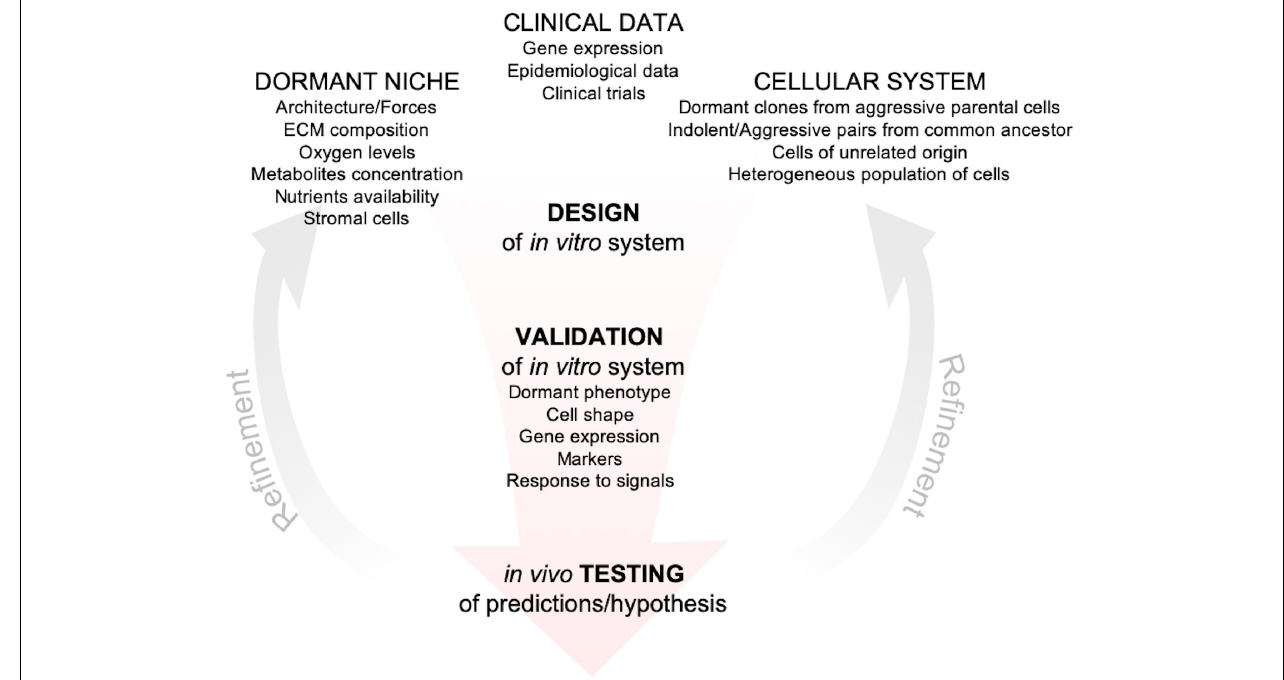
FIGURE 1 | Framework for the development of in vitro models of metastatic dormancy. In vitro models should include one or more features of the dormant niche starting from measurements/observations of the target metastatic tissue in vivo . Then cellular systems have to be chosen based on clinical evidences that support their specific use, i.e., correct metastatic tropism, correct gene expression (when available), correct response to signals (such as inflammation). After the initial setup, the in vitro system must be validated and the cell lines, as well as the microenvironment, should exhibit one or more features specific of the dormant phenotype (obtained from animal models or clinical data). The in vitro system should then be exploited to generate hypothesis and prediction that could be tested experimentally in animal models or from clinical data. Finally, according to the feedbacks from the in vivo validation, the system can be refined for more accurate predictions and